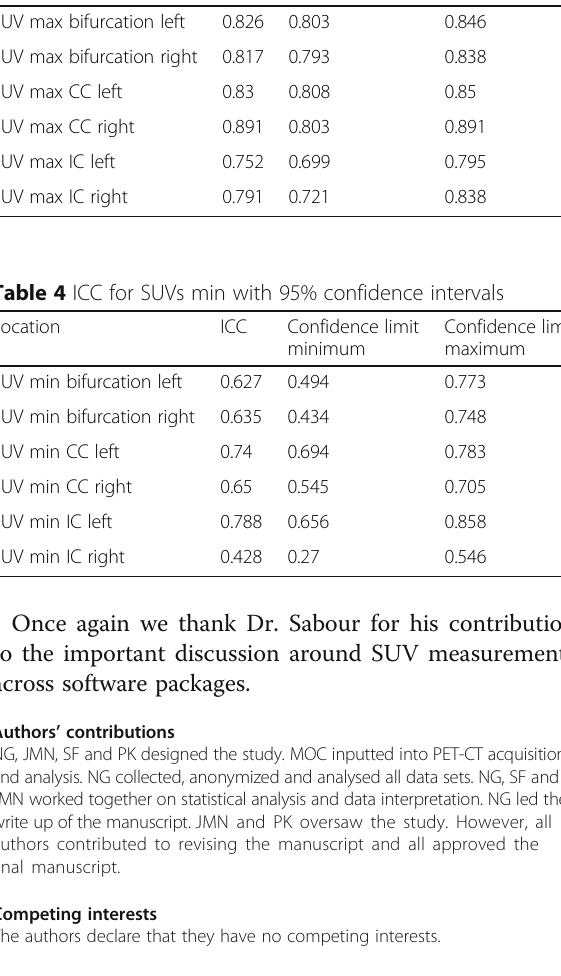
Table 3 ICC for SUVs max with 95% confidence intervals Location